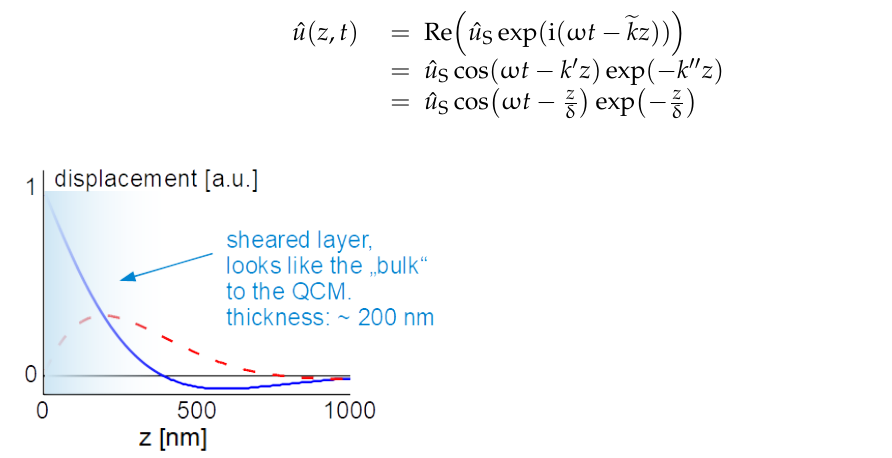
Figure 12. Displacement versus distance for a Newtonian liquid. The blue solid line is the real part, the red dashed line is the imaginary part of the shear wave. The depth of penetration is about 200 nm.